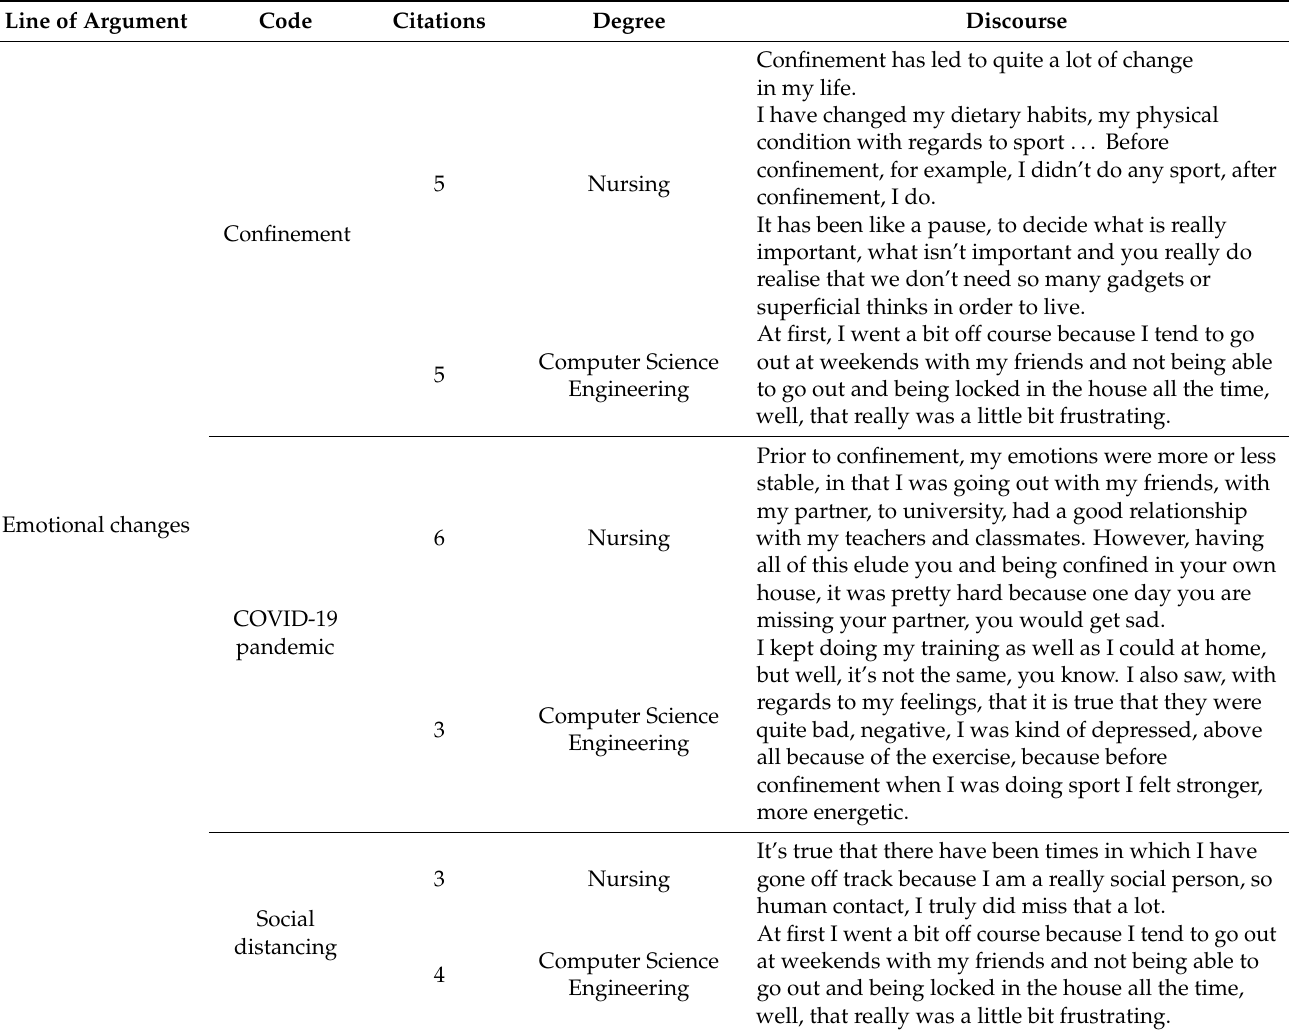
Table 5. Codes and nursing and engineering student discourse on the emotional changes experienced during the COVID-19